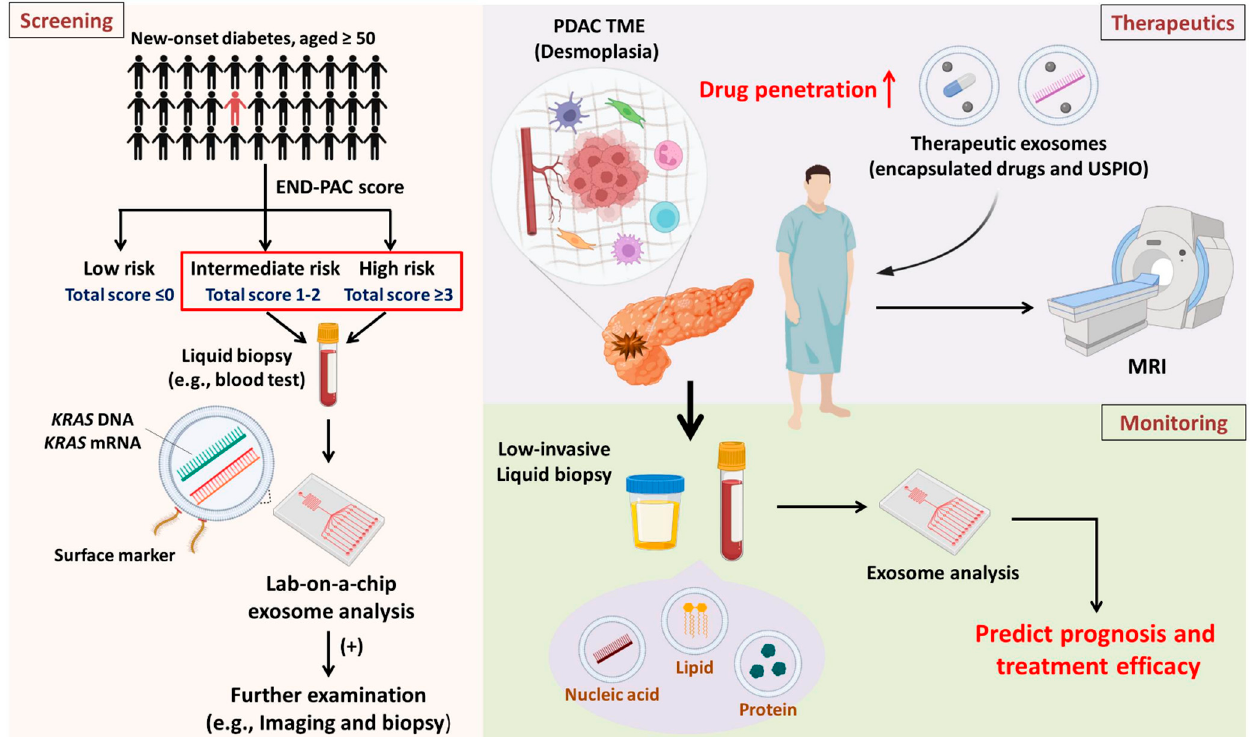
Figure 2. Overview and future perspectives Screening: Patients diagnosed with new-onset diabetes and aged ≥ 50 years are eight times more likely to develop PDAC. The high-risk population can be classified into three subpopulations according to the ENDPAC score. It is suggested that high-risk and intermediate-risk subpopulations receive regular blood tests for exosomal analysis to identify patients suspected of having PDAC early for further examination. Therapeutics: PDAC is characterized by desmoplasia, which compromises drug entry into malignant lesions. Drug candidates and USPIOs can be encapsulated in exosomes to improve drug entry and enable the detection of drug distribution via noninvasive imaging approaches. Monitoring: After treatment, it is important to investigate therapeutic efficacy. Analyzing exosome contents by liquid biopsies (which have low invasiveness) can provide physicians with immediate information about patient prognosis and response to